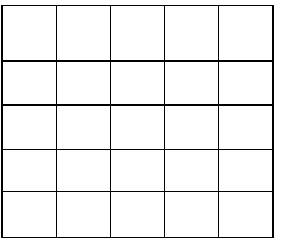
Figure 2. The Event Matrix in